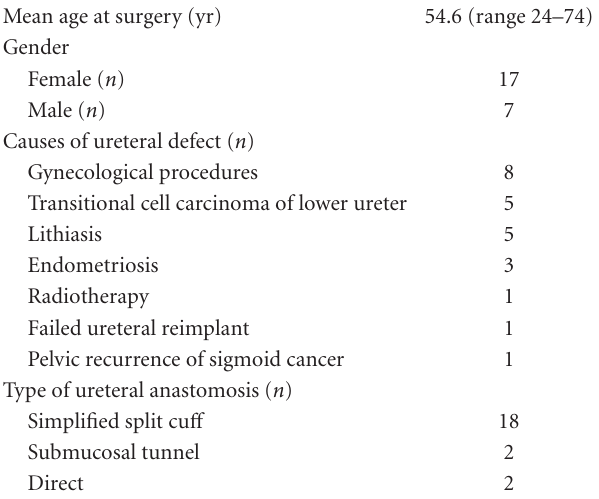
Table 1: Patients’ characteristics.